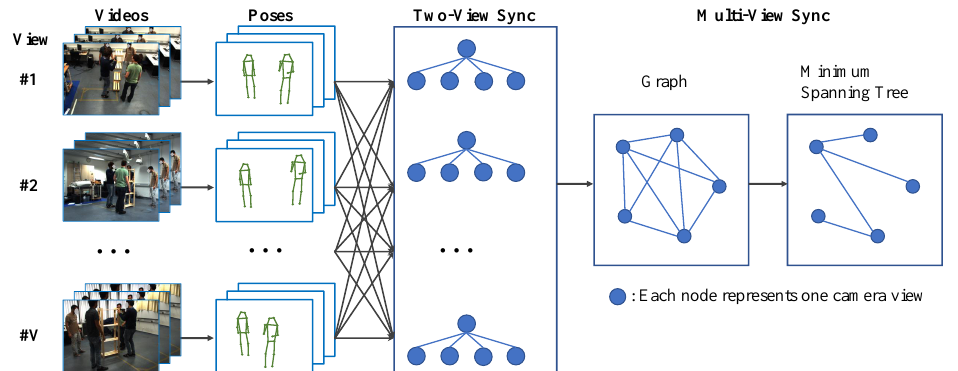
Figure 1. Overview of our method. V is number of camera views (V = 5 in this illustration). It first takes video frames from multiple views as input and outputs 2D human poses using an out-of-the- shelf HigherHRNet [17]. Then, we find the optimal offset and the corresponding minimal energy between each pair of views by the two-view synchronization method (Section 4). Finally, we form a fully connected graph whose nodes are camera views and derive the optimal offsets’ configuration for the multiple-camera system by minimum spanning tree algorithm (Section 5). Human faces are obfuscated to protect subjects’